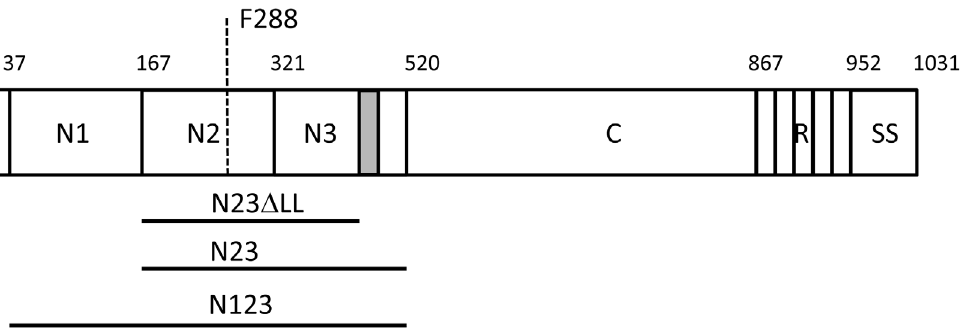
Figure 1. Schematic diagram of SpsD. The A domain modelled on the structure of ClfA spans residues 37–519 following the secretory signal sequence S. This is followed by a connecting region C (residues 521–867) and a repeat region R in strain ED99. The number of repeats varies from strain to strain resulting in proteins of slightly different sizes. A sorting signal (SS: LPXTG motif, hydrophobic domain and positively charged residues) occurs at the extreme C-terminus. The minimum ligand binding domain construct N2N3 spans residues 167–519. Residues comprising the ‘lock’ and ‘latch’ (grey box residues 490–499) are indicated (N23 D LL). Residue F288 that is predicted to lie within the ligand binding trench is indicated by the dashed line.